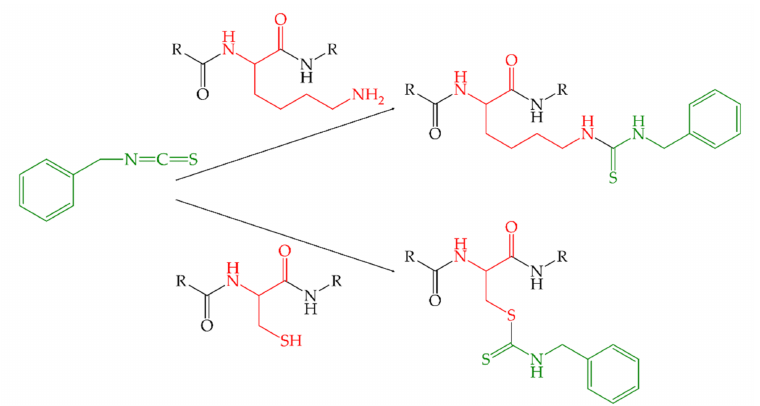
Figure 1. Reaction of benzyl isothiocyanate (BITC) with nucleophilic groups, e.g., of protein side chains. Top: reaction with an amino group to form a thiourea. Bottom: reaction with a thiol group to form a dithiocarbamate, redrawn from